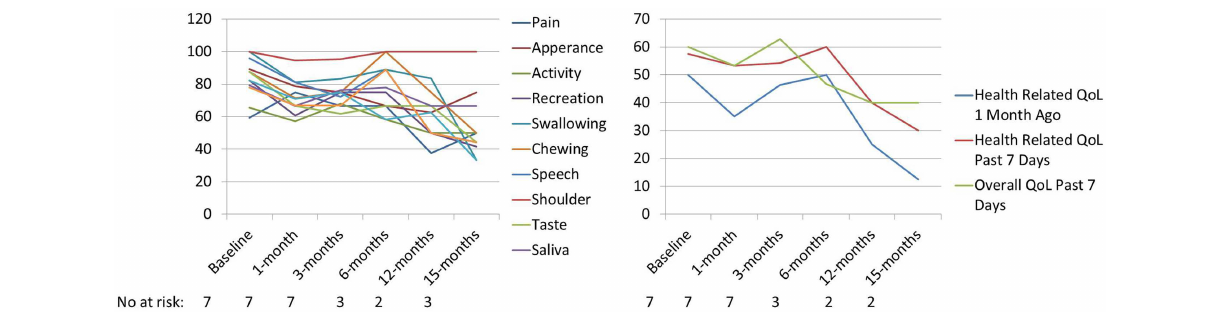
1 week; consistent with prior reports for QoL outcomes fol- lowing SBRT for recurrent previously irradiated head and neck cancers